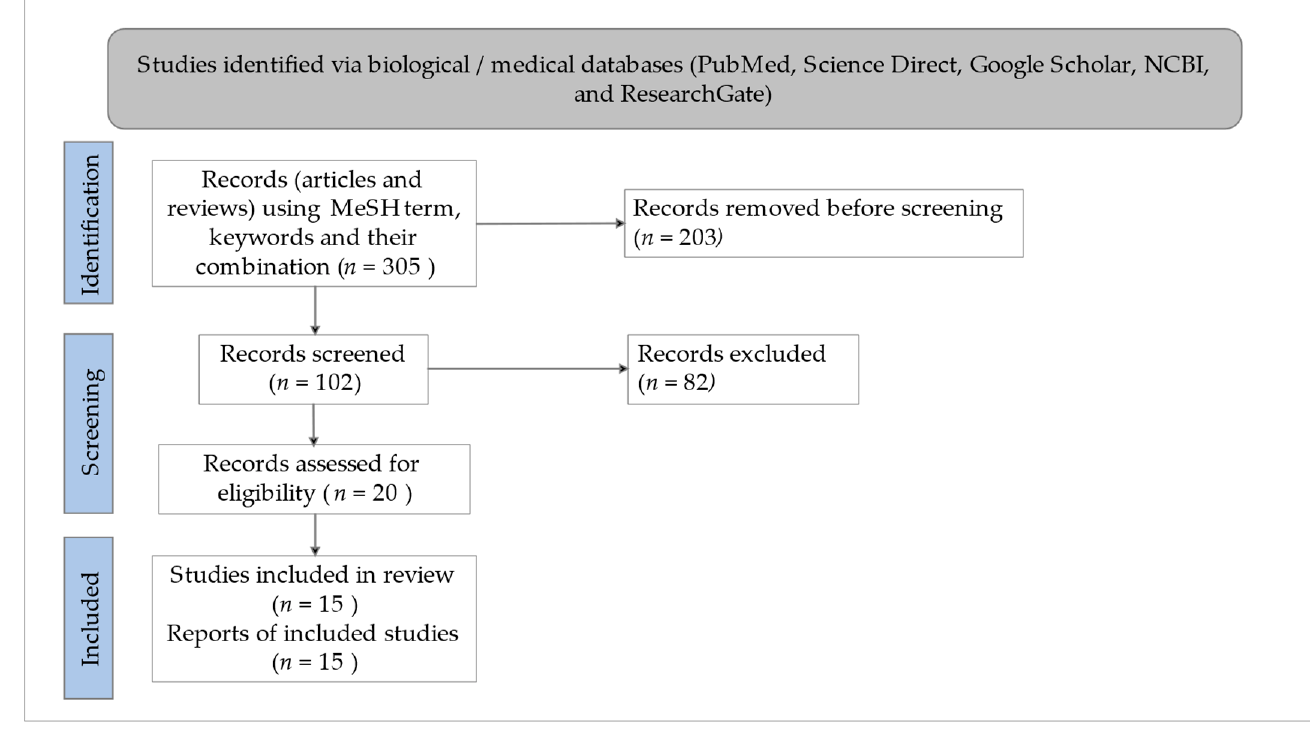
Figure 1. PRISMA flow chart of selecting the relevant studies.